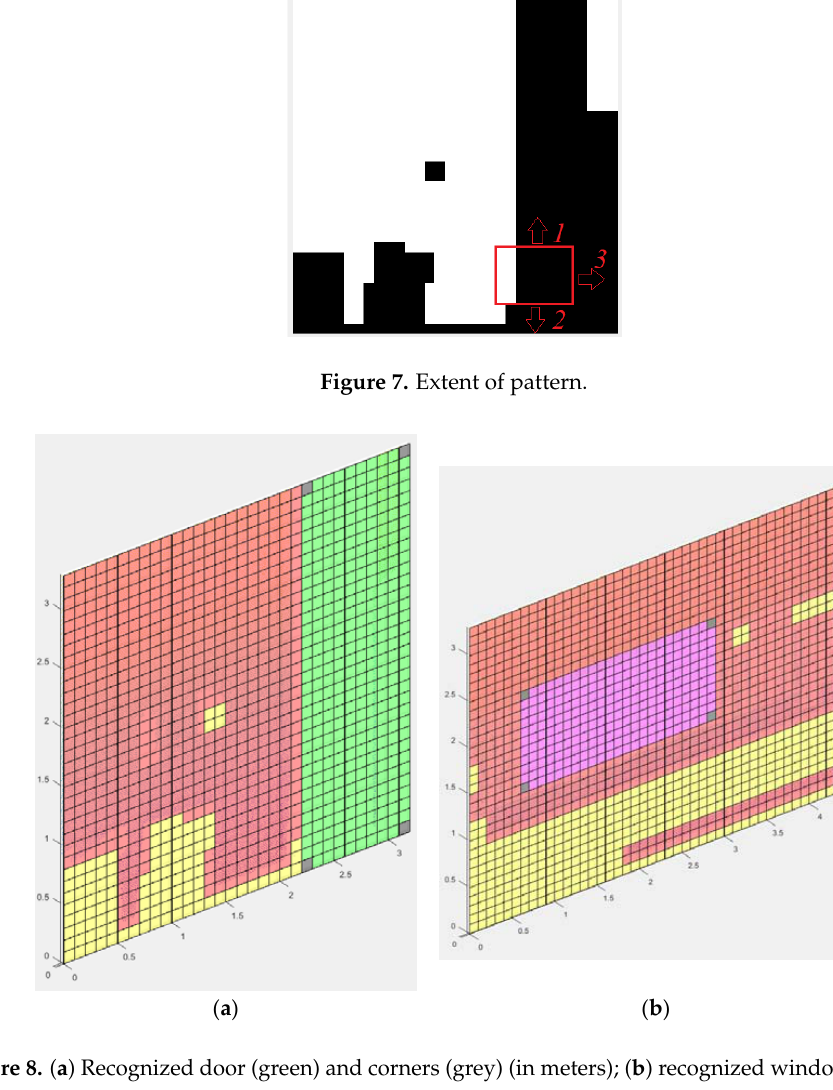
Figure 8. ( a ) Recognized door (green) and corners (grey) (in meters); ( b ) recognized window (magenta) and corners (grey) (in